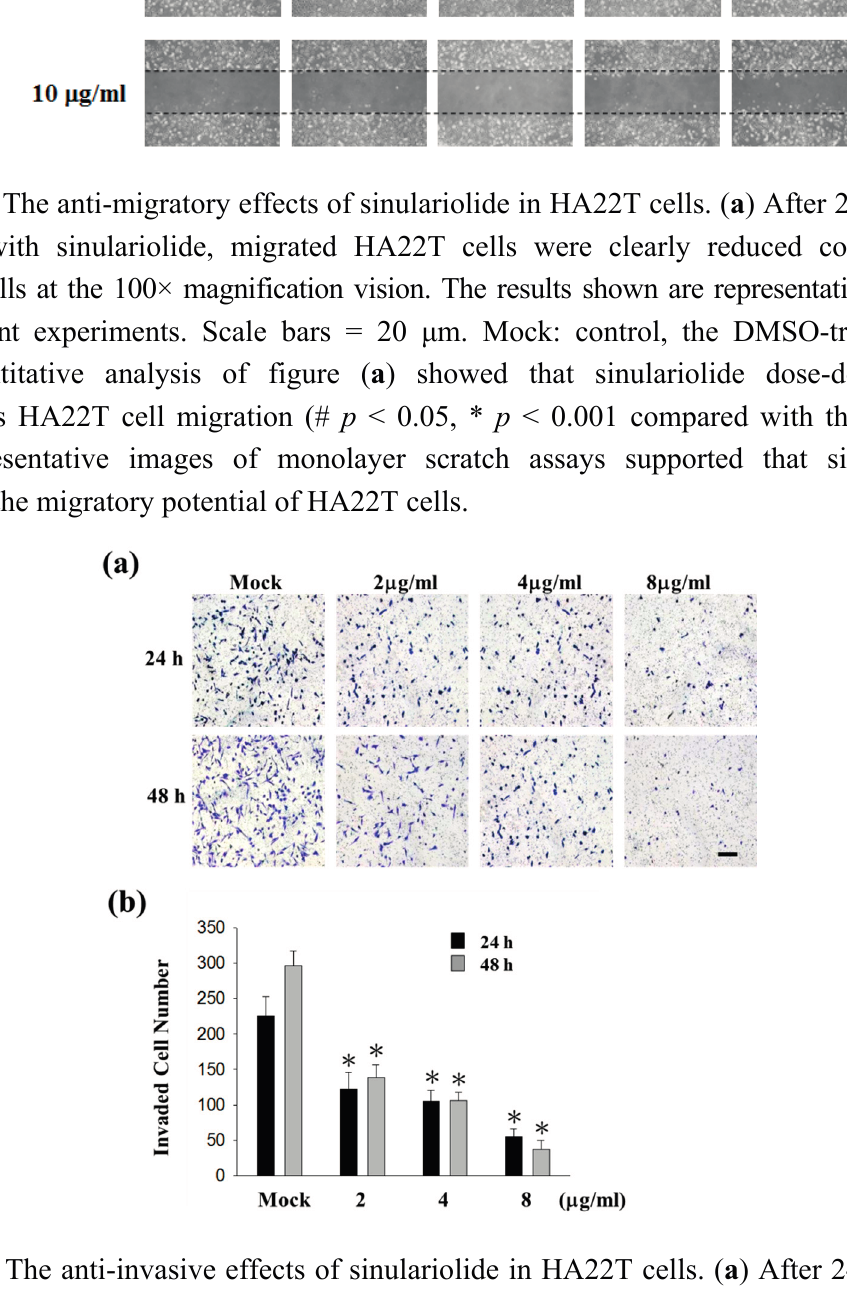
Figure 2. The anti-invasive effects of sinulariolide in HA22T cells. ( a ) After 24 and 48 h treating with sinulariolide, invaded HA22T cells were clearly reduced compared to control cells at the 100× magnification vision. The results shown are representative of three independent experiments. Scale bars = 20 μ m. Mock: control, the DMSO-treated cell; ( b ) Quantitative analysis of figure ( a ) showed that sinulariolide dose-dependently suppresses HA22T cell invasion (* p < 0.001 compared with the